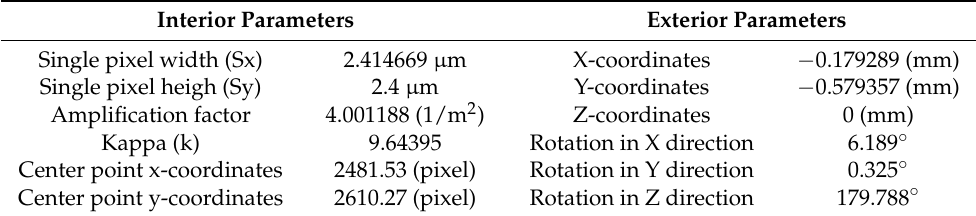
Table 3. Calibrated parameters of the right camera.